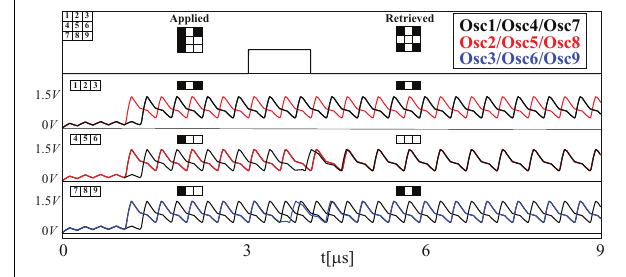
FIGURE 8 | Waveforms corresponding to one of the experiments illustrated in Figure 7 .